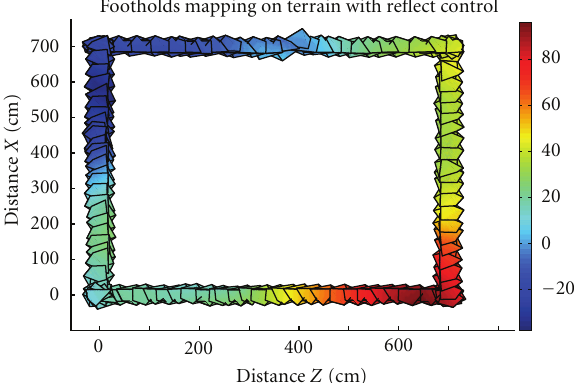
Figure 16: Terrain intercepted by the robot using the FRC